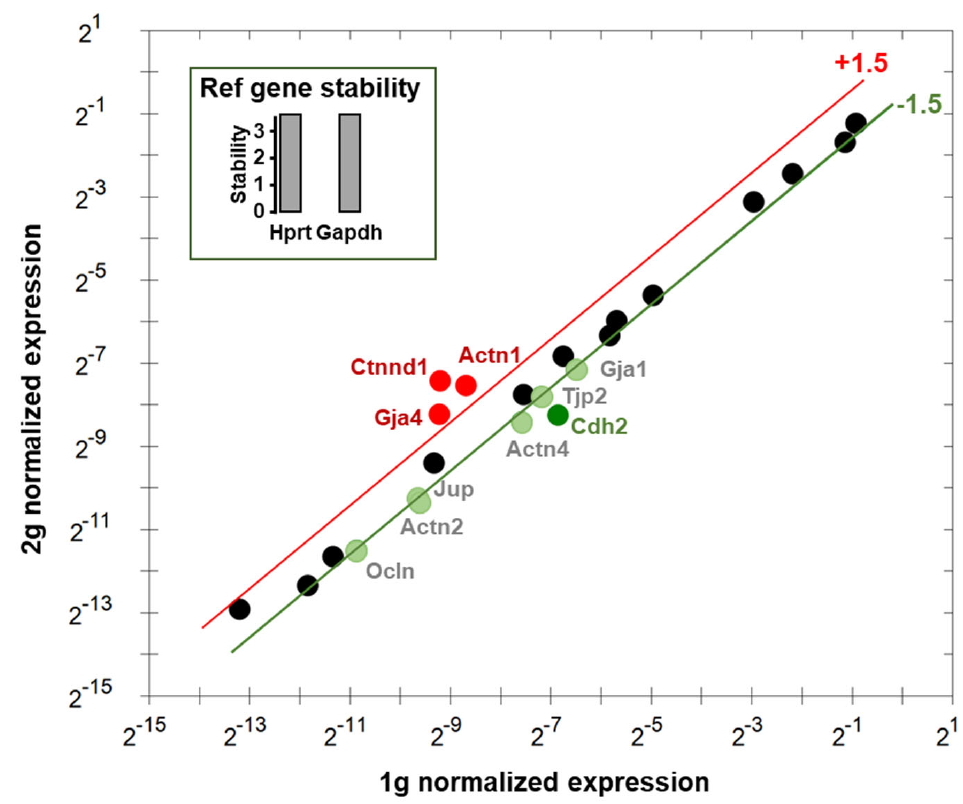
Figure 7. Relative expression of genes involved in endothelial cell contacts. The gene expressions in 1 g and 2 g were compared using Hprt and Gapdh as reference genes (in inset). The upregulated and downregulated genes are indicated in red and green, respectively. Genes indicated in black are considered not affected. Table 1. Relative expression and functions of genes modulated by 2 g.